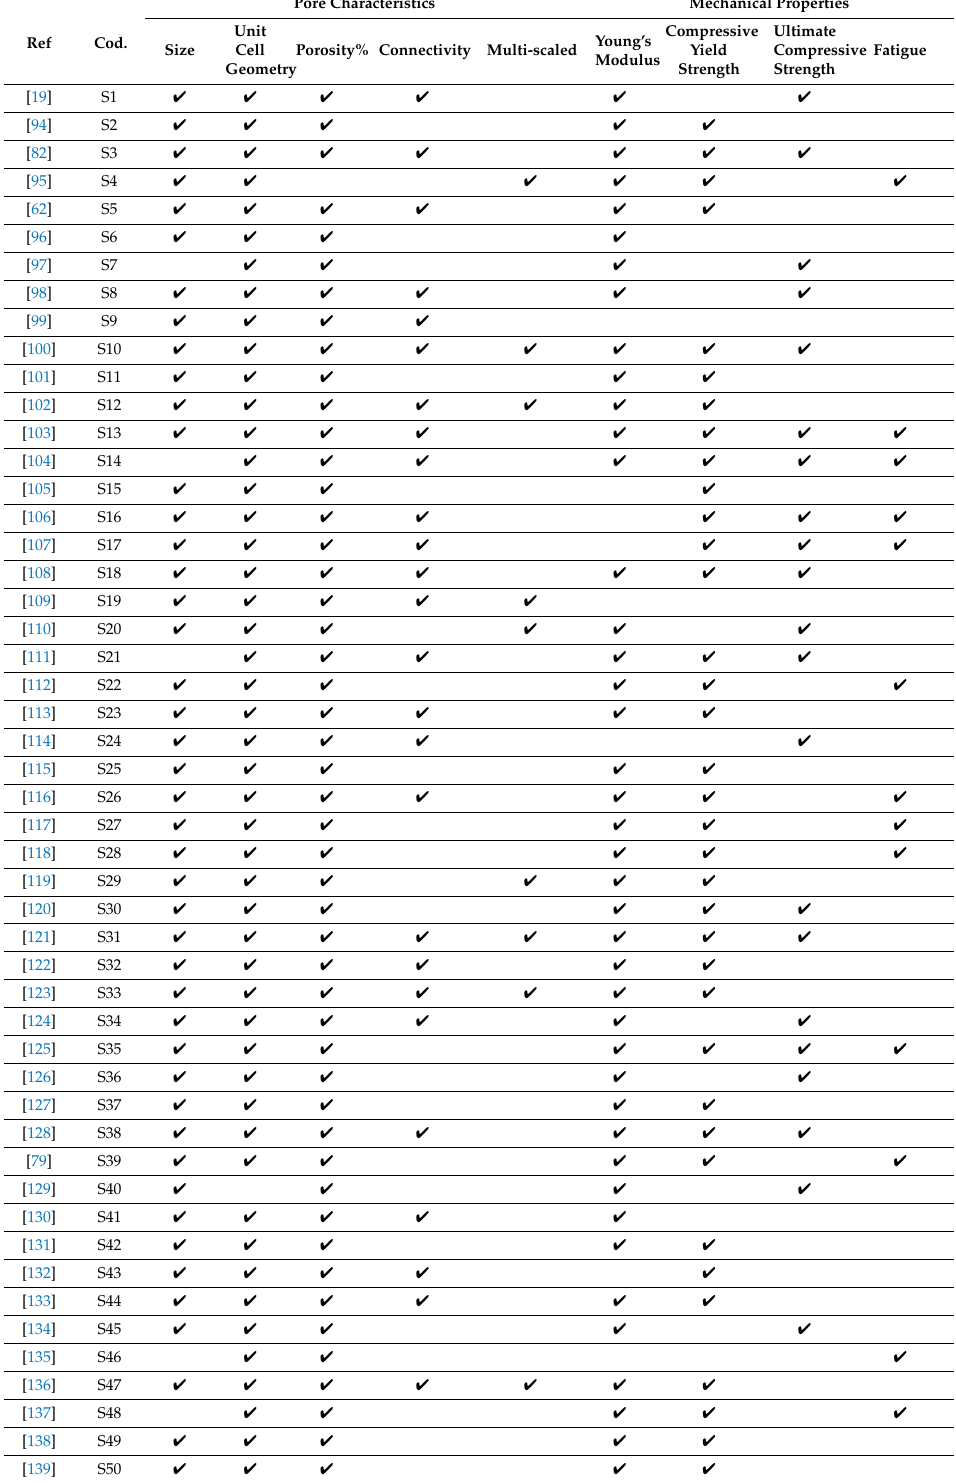
Table 3. Studies selected in the systematic search according to information related to additively manufactured (AMd) porous Ti structures’ mechanical, geometrical, and dimensional